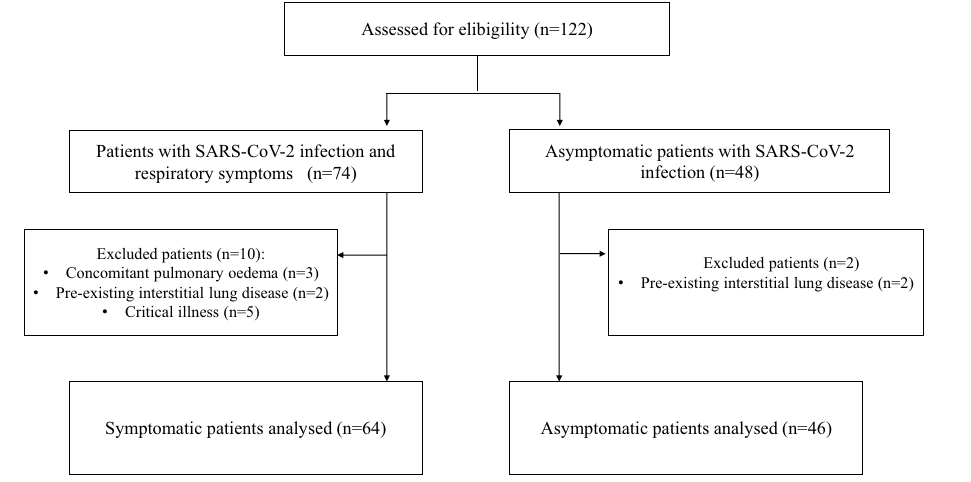
Figure 1. Flow chart of the observational cohort study.